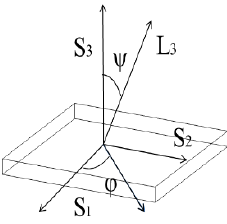
Figure 2. Schematic of the macroscopic stress analysis.